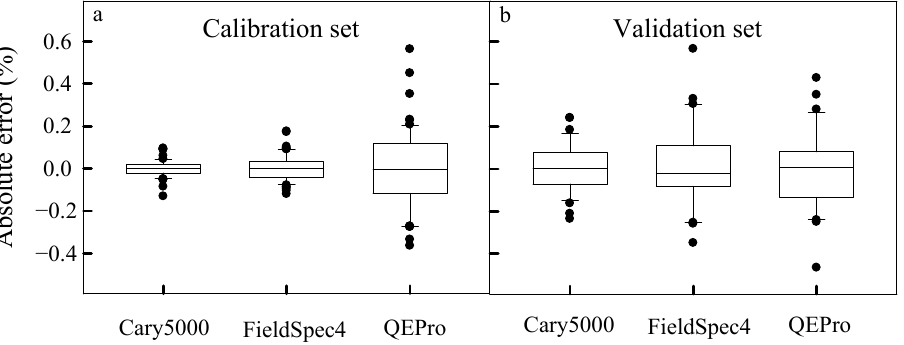
Figure 6. The quartile map of the absolute error for predicted organic carbon concentrations in the calibration set and validation set (absolute errors in the calibration set ( a ) and validation set ( b )). Secondly, the spectral curves were close to a normal distribution, except for the cali- bration set of FieldSpec 4 (Figure 7). Cary 5000 had a wider detection range of SOC than range than the validation set, showing a consistent detection range of SOC (Figure 7). results were consistent with those in Table 3.